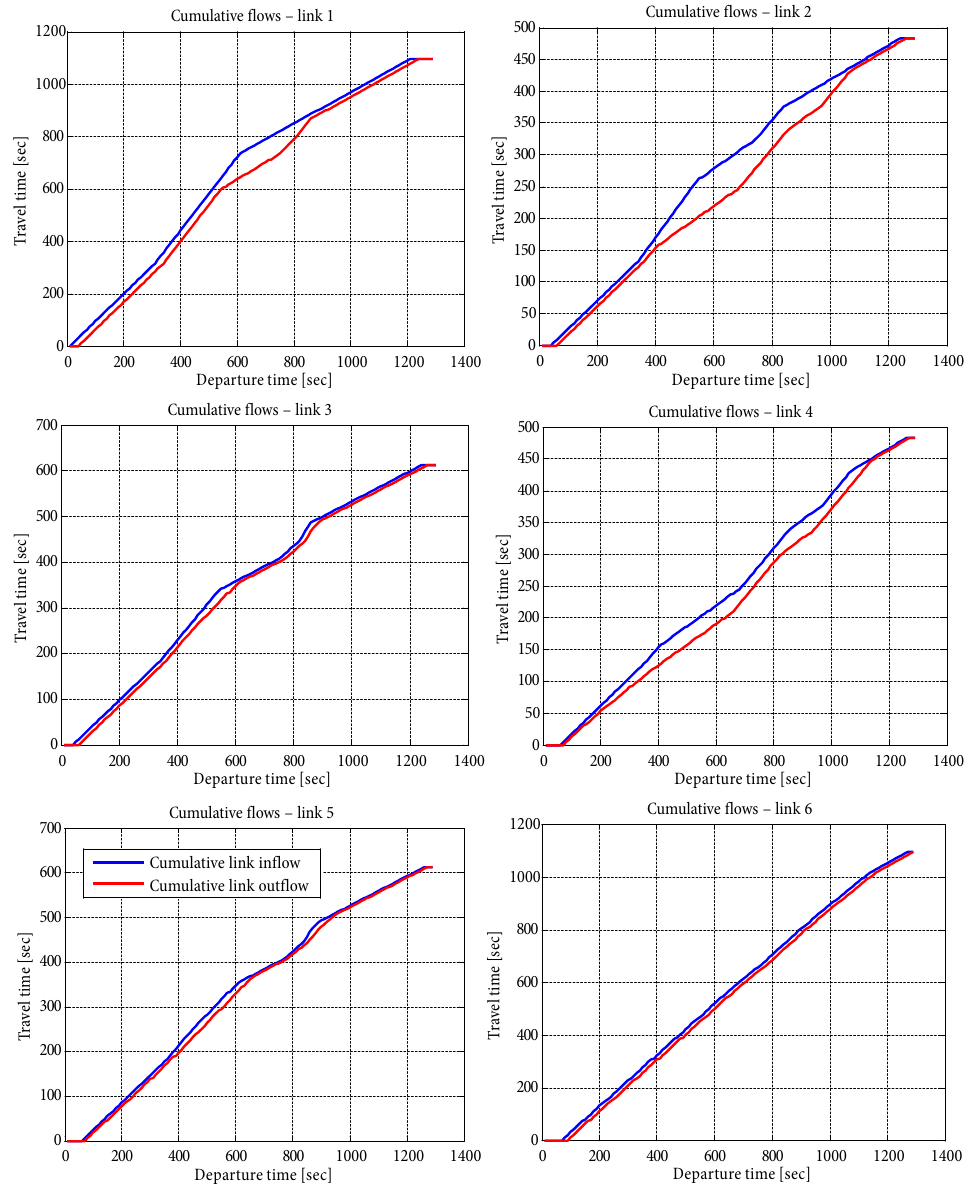
Fig. 4. Cumulative flows for single-class Fig. 7 represents the travel times obtained for time reaches around 320 seconds in the DQTM, while each route and each vehicle type for the DQTM and in the DQM it is around 200 seconds. For class 2, the the DQM. It can be noticed a significant difference in difference is the same, only that the travel times are even travel times between different vehicle classes, with class higher and reach 400 seconds for the DQTM and about 2 having a higher travel time for both routes and both 325 seconds for the DQM. Moreover, the queue on route models. Since this vehicle class has indeed a lower speed 1 dissolves more slowly in the DQTM and it is present (Table 2), the longer travel time is correctly captured by until almost the end of the departure time (since the the models. However, the values of the travel times for travel time is higher than the free flow travel time until the two models are substantially different. For route the end of the departure time period). As for route 2, 1, the travel time in both models has a free flow value in the DQM both vehicle classes travel with their free (90 seconds for class 1 and 180 seconds for class 2) for flow speeds during the entire departure time period and around 300 seconds of the simulation (when the demand there is no queue. In the DQTM, a queue forms on route is less than the network capacity) and starts increasing 2 as well, and it results in the increased travel time for with the increase in the demand. However, it can be seen both vehicle classes. For class 1, the vehicles departing that the DQTM has a higher travel time on route 1 than after 300 seconds experience a queue, which is present the DQM for both vehicle classes. For class 1, the travel until 900 seconds of the departure time. For class 2, the